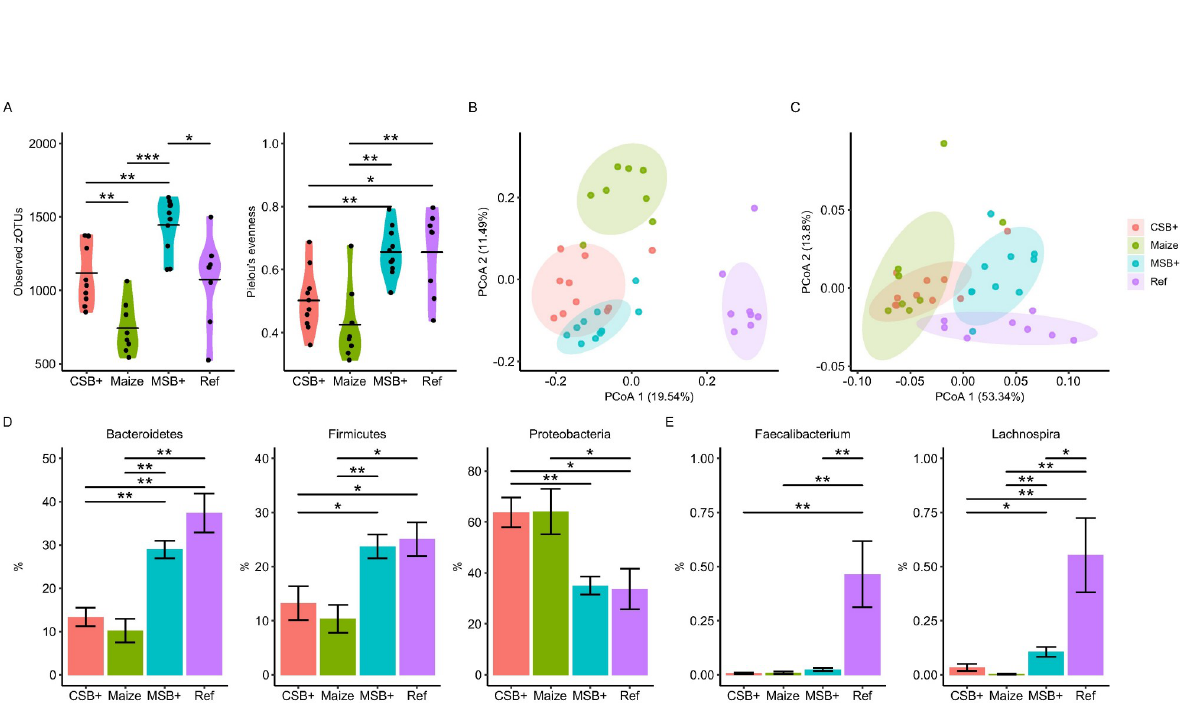
Fig 3. Colon mucosal microbiota shifts determined by the 16S rRNA gene amplicon sequencing. Observed zOTU numbers and Pielou’s evenness (A). PCoA plot of unweighted (B) and weighted (C) UniFrac distance metrics; the colored ellipses indicate 80% confidence level following multivariate t-distribution. The relative abundance of Bacteroidetes , Firmicutes and Proteobacteria between groups (D). Differentially abundant Faecalibacterium and Lachnospira spp. identified by ANCOM. (E). For CSB+ and MSB+, n = 10; For Maize and Ref, n = 8. Data in the bar plot was shown by mean value together with SEM error bar. The labels of � , �� , ��� represent adjusted p < 0.05, < 0.01 and < 0.005 respectively.